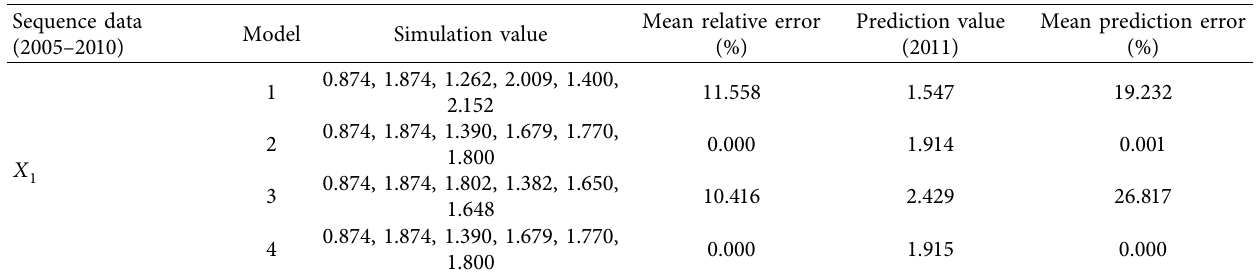
Table 1: Comparison of modeling accuracy of four models based on four stochastic oscillation sequences with diferent amplitudes. Sequence